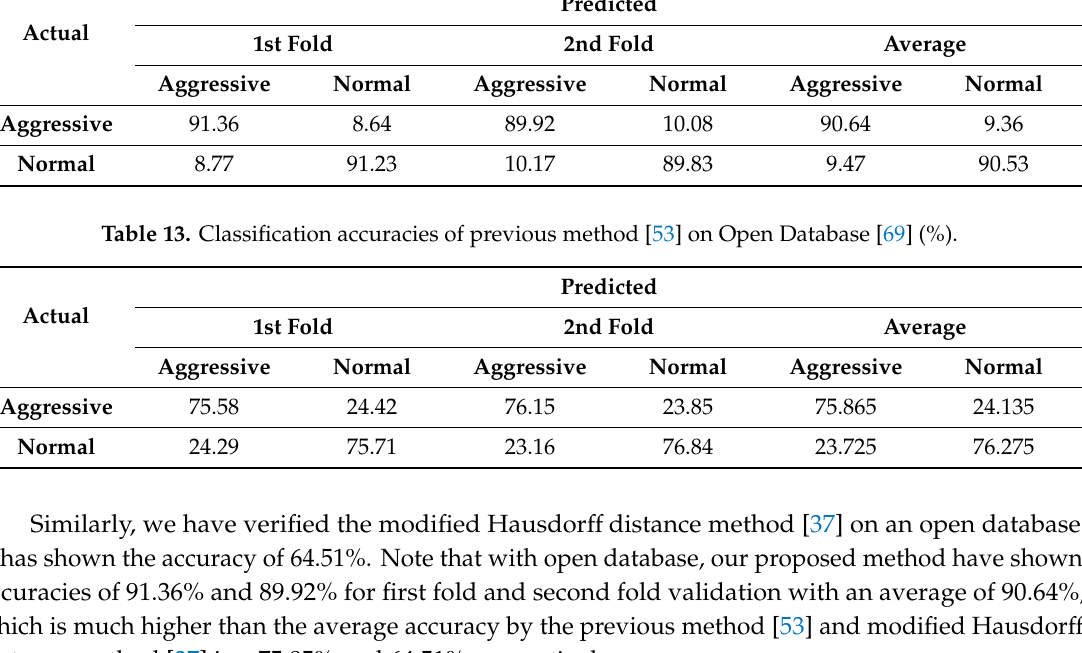
Table 12. Classification accuracies of proposed method on Open Database [69] (%).